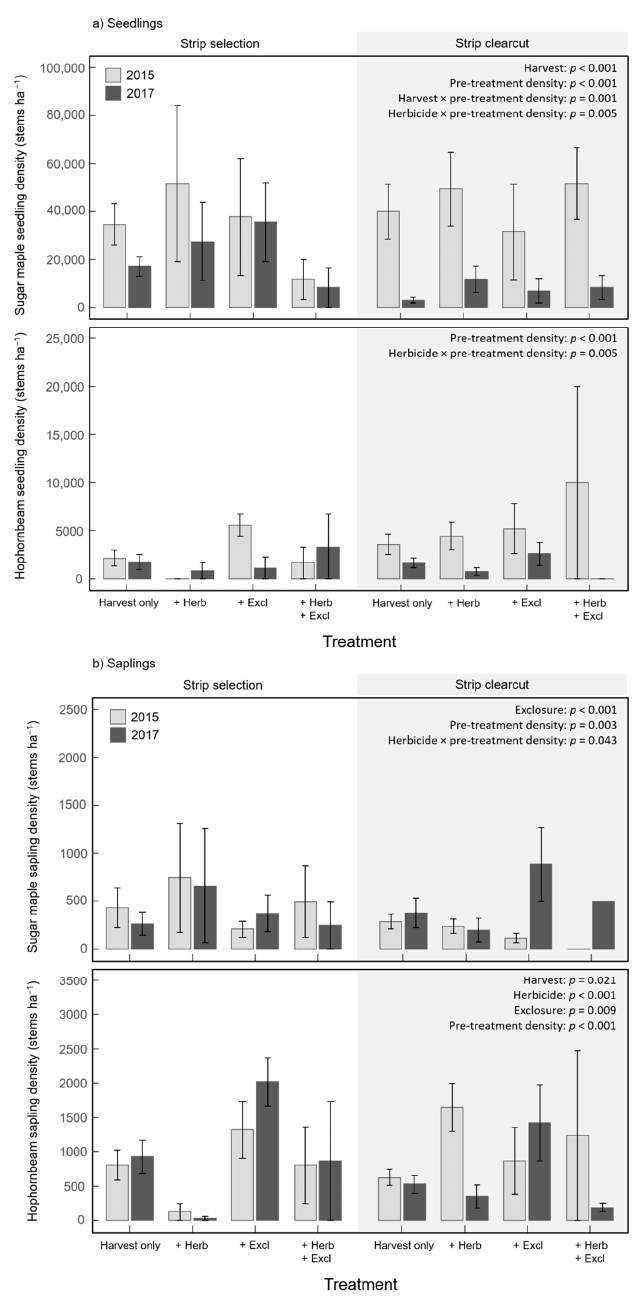
Figure 2. Sugar maple ( Acer saccharum Marsh.) and hophornbeam ( Ostrya virginiana ((Mill.) K. Koch) seedling (<45.7 cm tall) and sapling (>45.7 cm tall, <15.2 cm dbh) density among harvest, herbicide (Herb), and exclosure (Excl) treatments in a managed northern hardwood forest in the Upper Peninsula of Michigan, USA. Note the different y -axis